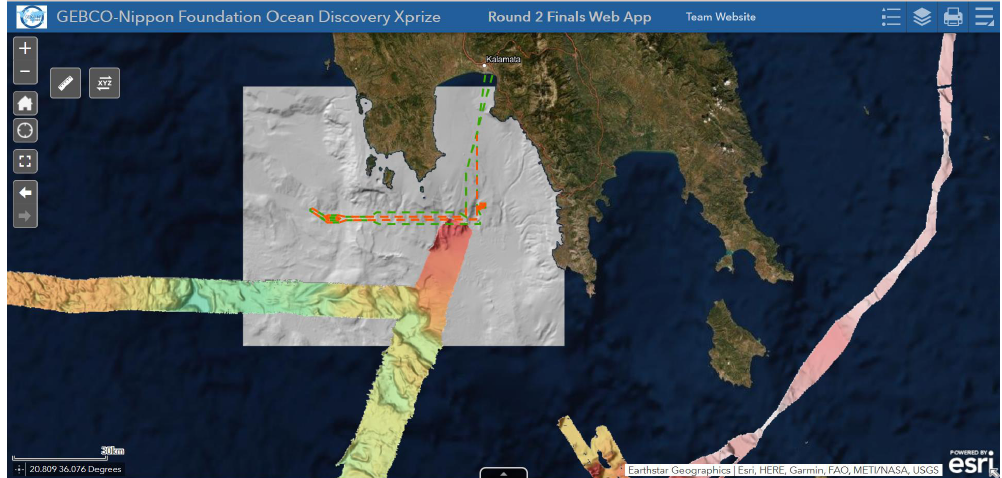
Figure 5. The ESRI ArcGIS Web App, an example of online GIS tools, utilized by the team for data sharing, visualization, analysis, and decision